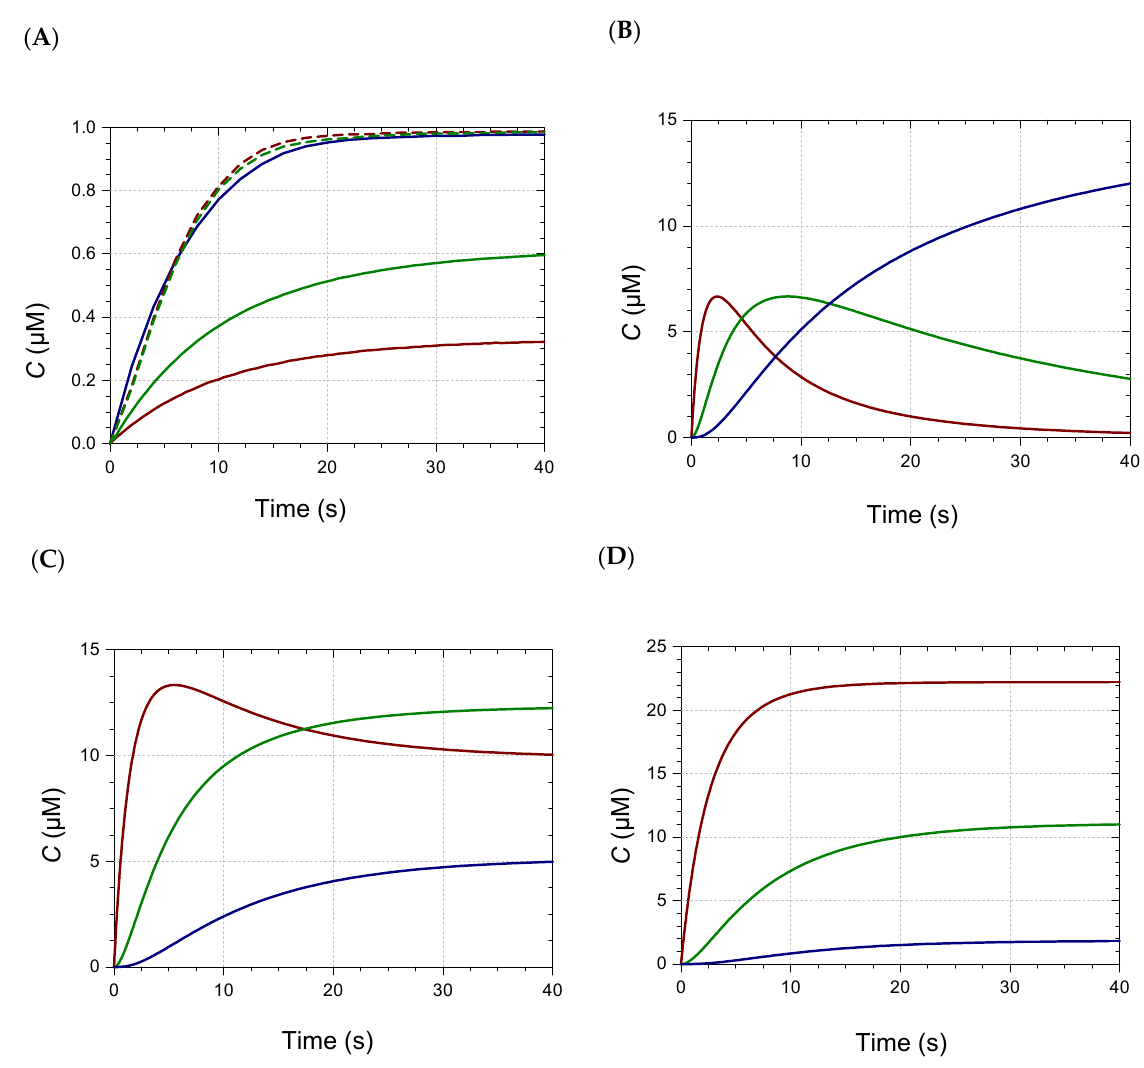
Figure 2. ( A ) Kinetics of Fe 2+ –Pigment B binding (pH 7, 25 °C). Pigment concentration = 50 µM, metal/pigment molar ratio = 0.05 ( ▬ ), 0.1 ( ▬ ), 0.3 ( ▬ ), 0.6 ( ▬ ▬ ), 1 ( ▬ ▬ ). ( B – D ) Speciation diagrams of Fe 2+ –Pigment B complexes. ( B ) 0.3 equiv. Fe 2+ . ( C ) 0.6 equiv. Fe 2+ . ( D ) 1 equiv. Fe 2+ . ML ( ▬ ), ML 2 ( ▬ ), ML 3 ( ▬ ). ML n : metal–ligand complex having a 1:n metal/ligand stoichiometry.